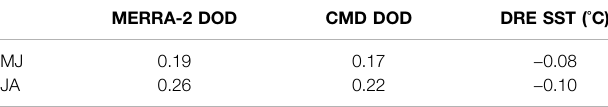
TABLE 3 | The regional mean DOD from MERRA-2 reanalysis, CMD simulations and the SST anomaly (unit: ° C) induced by dust DRE over the Arabian Sea (10 – 25 ° N, 55 – 70 ° E) during the early and the late monsoon seasons,